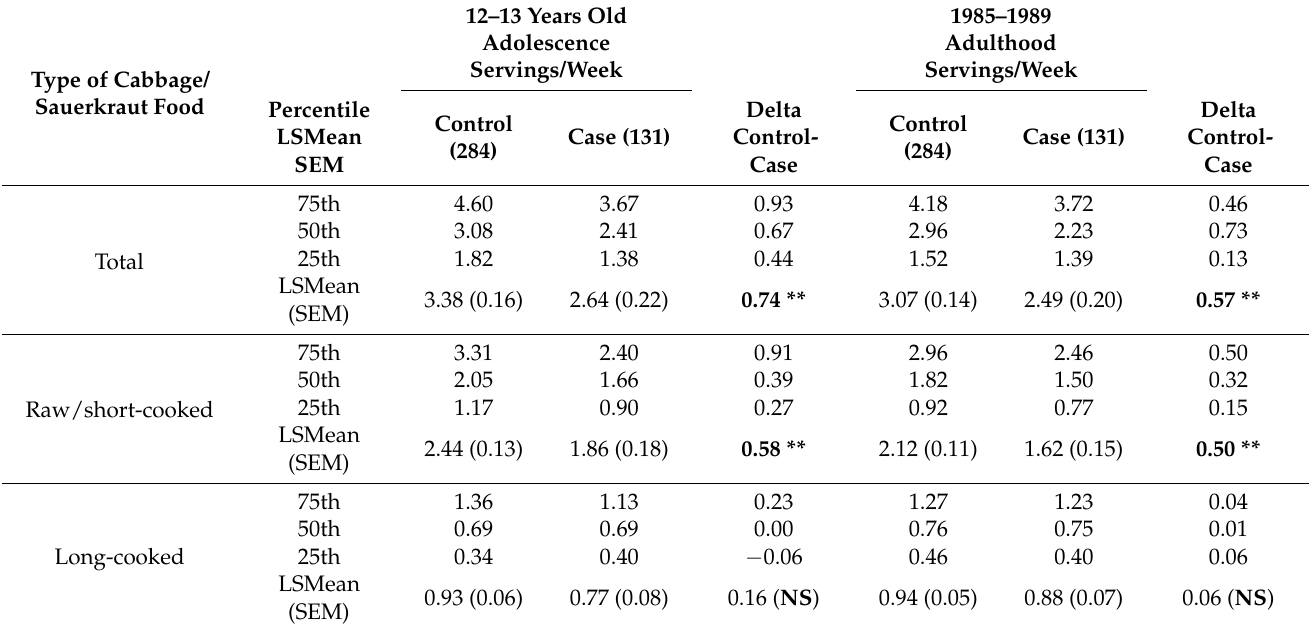
a Least square means (LSMean) and standard error of the mean (SEM) adjusted for age at diagnosis(cases) or interview (controls) (<35 y; 35–44 y; 45–54 y; 55–64 y; 65–74 y; ≥ 75 y) and site (Cook County, DMA). For DMA (ages < 35 y; 35–44 y) were combined due to small sample size; ** bold represents p ≤ 0.01; (NS)-not